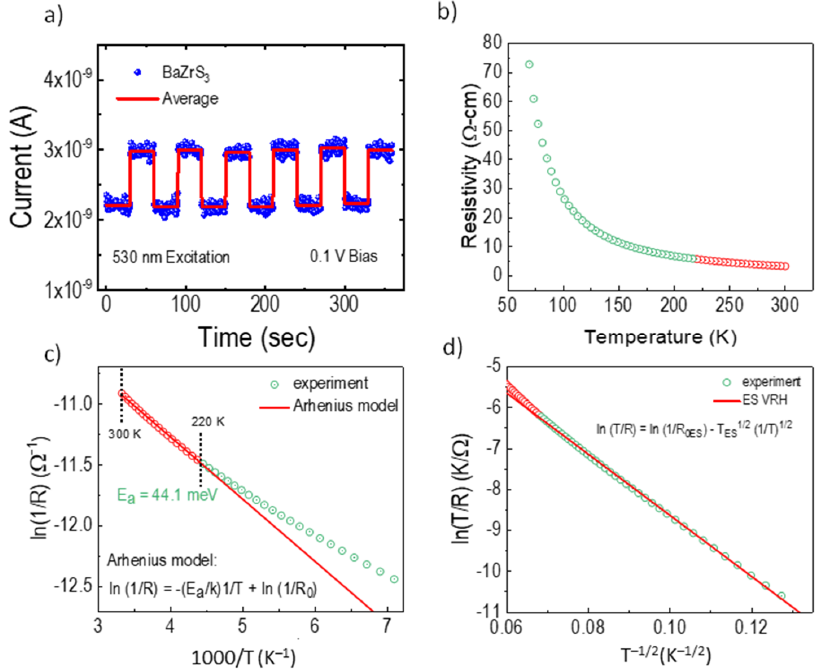
Figure 4. ( a ) Photogenerated current of BZS films illuminated by an LED at an excitation wavelength of 530 nm, an output power of about 38 mW, and 0.1 V bias measured at room temperature. ( b ) Temperature dependence of resistivity measured using a four-probe configuration. ( c ) Linear fit of the experimental data using an Arrhenius model. A divergence of the fitting starts at a temperature lower than 220 K. ( d ) Linear fit of experimental data using an E-S variable range hopping model at temperatures lower than 220 K. The red and green circles are used to show the experimental data at temperatures above and below 220 K, respectively.